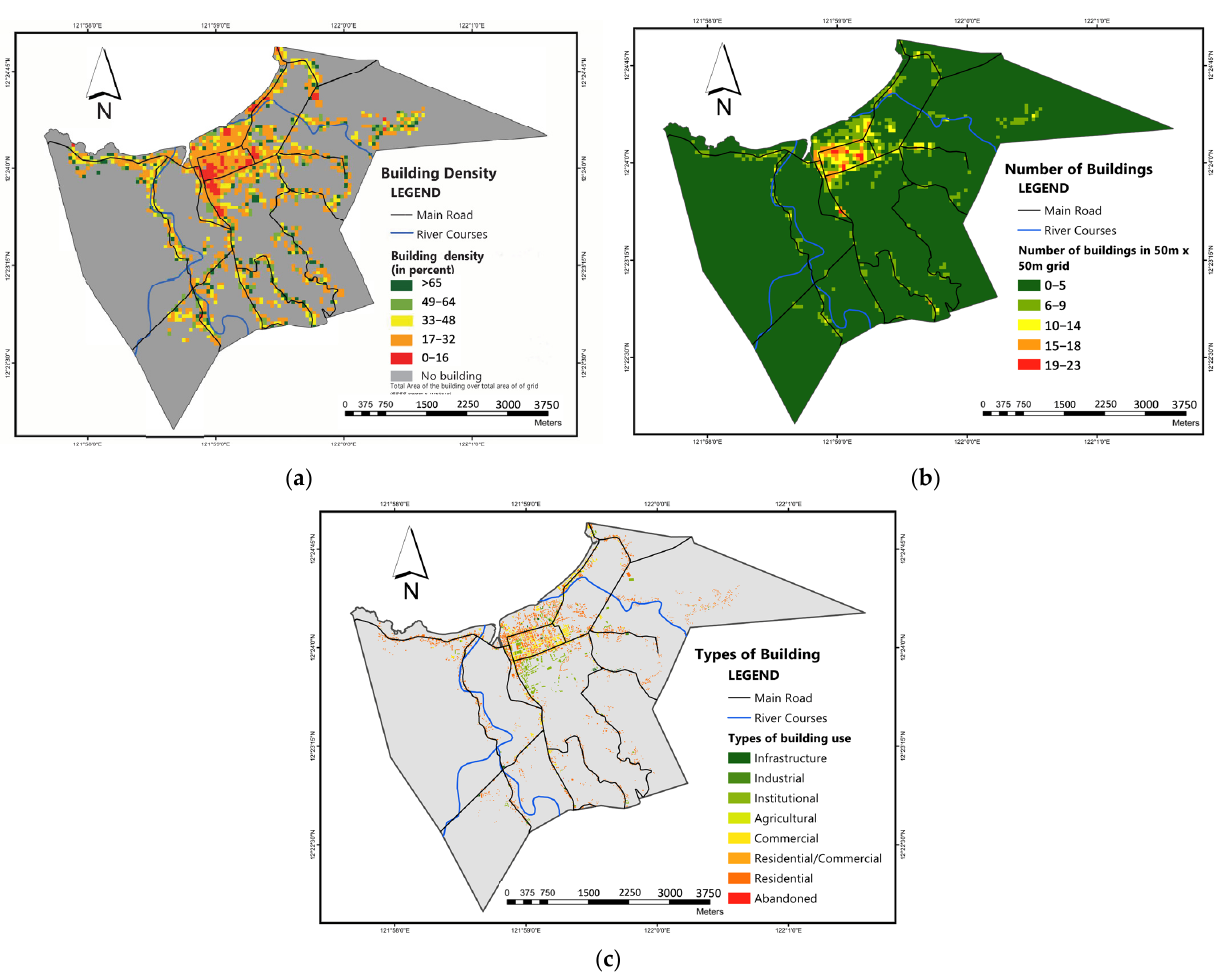
Figure 5. Result maps for building flood exposure parameters using ArcMap: ( a ) building density, ( b ) number of buildings per grid, and ( c ) type of building use.